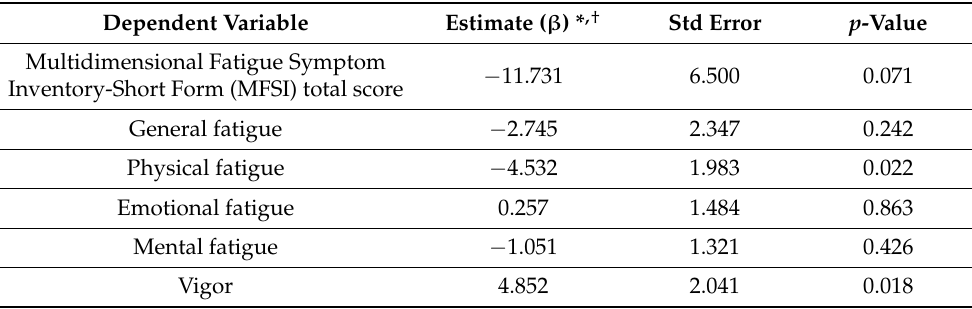
Table 4. Associations between change in circulating omega-3 fatty acids and change in fatigue among cancer survivors who were supplemented with fish oil ( n =